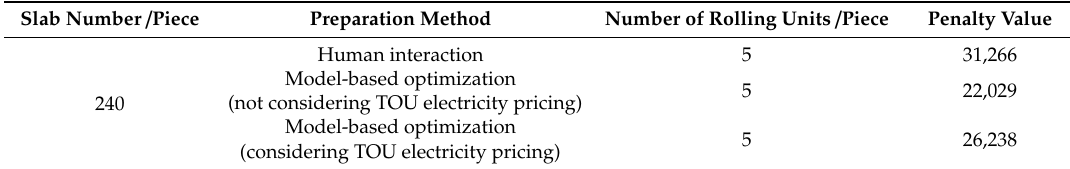
Table 5. Penalty values of three hot-rolling batch-processing plans.